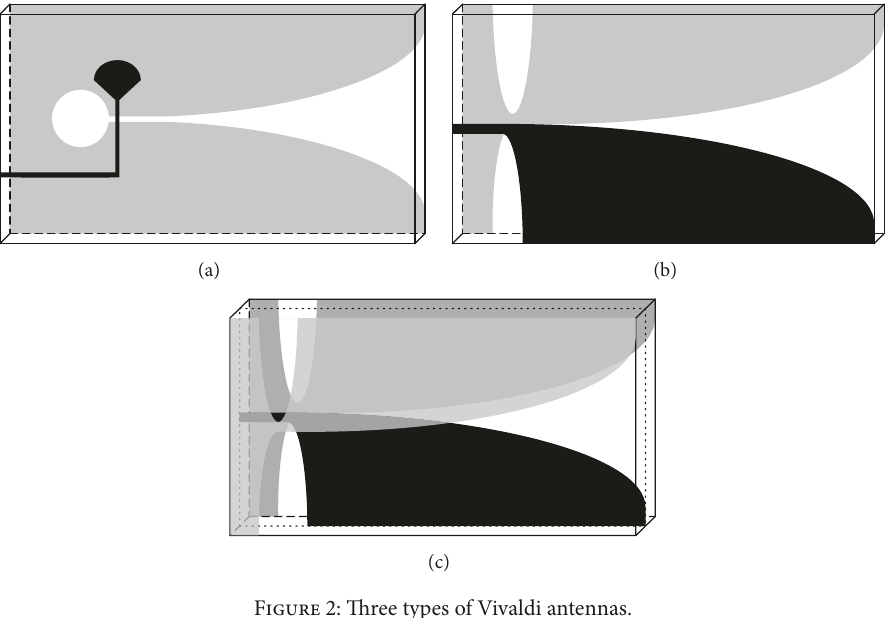
Figure 2: Three types of Vivaldi antennas.